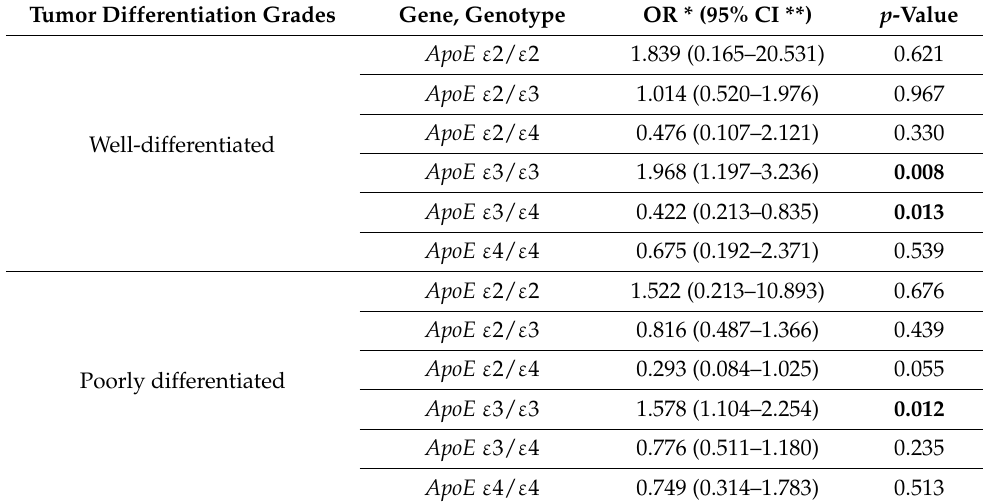
Table 11. Binary logistic regression analysis of ApoE in the control group and LSCC patient subgroups with different tumor differentiation grades.